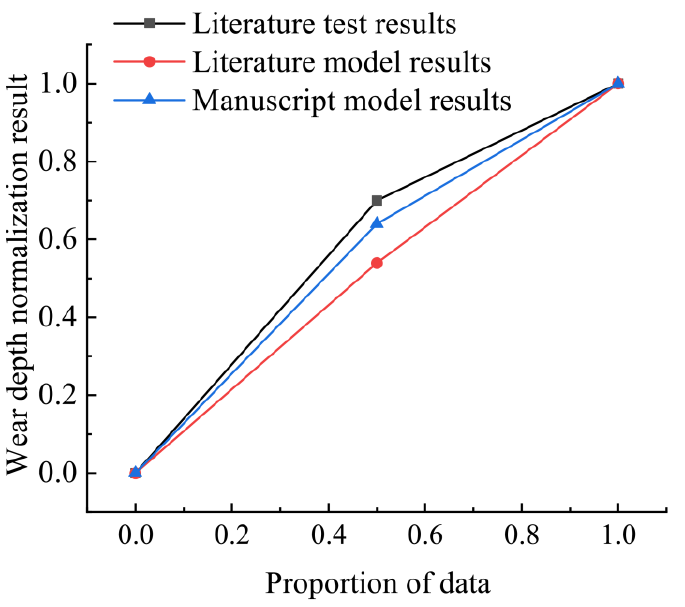
Figure 15. Comparison and analysis of normalization results.